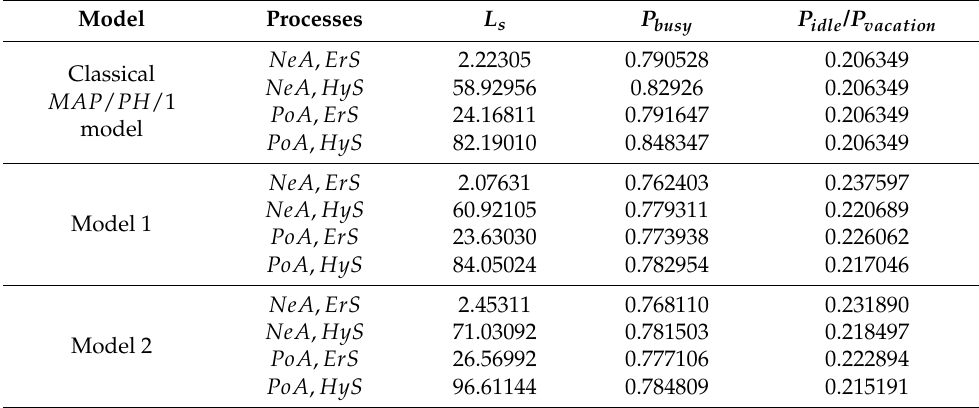
Table 1. Performance measures for classical MAP / PH /1 model, Model 1, and Model 2.